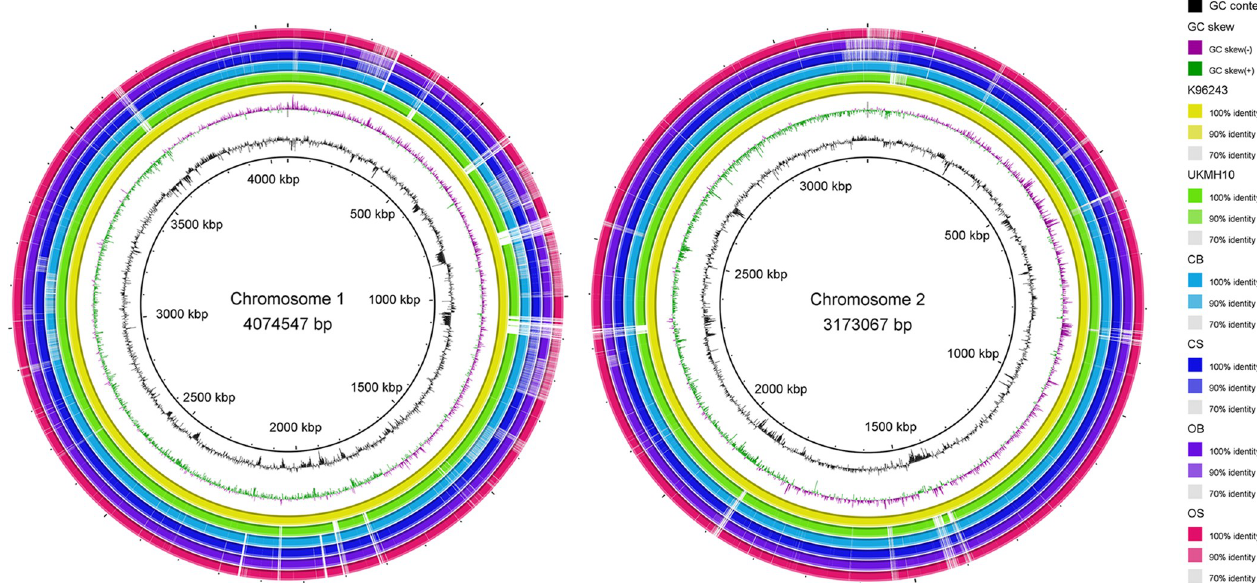
+ cytosine sites divided by DNA sequence length) of 68.2%. The genome size and GC content were similar to the reference genome B . pseudomallei K96243 (7,247 Kbp; 68.2%) [27]. The draft genome of all four strains showed an average N50 value of ~80 Kbp and a high total genome coverage ( � 144 × ). Genome annotation using RAST revealed that CB, CS, OB, and OS contained 7,460, 7,401, 7,388, and 7,360 predicted coding DNA sequences (CDSs), respec- tively. A summary of the genomic features of these draft genomes are presented in Table 2. The four draft genomes and UKMH10 were compared in reference to B . pseudomallei K96243 genome. A visual representation of the genomic similarity between these five genomes was depicted by the concentric rings in Fig 2. The missing portions of the rings represented the missing nucleotides in the genomes as compared to B . pseudomallei K96243 genome. Overall, all five genomes were highly similar to each other as the genomes shared most of the same missing nucleotides regions.